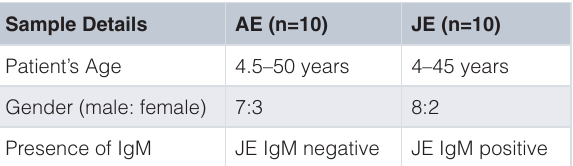
Table 1. Details of the cerebrospinal fluid samples from AES and JE